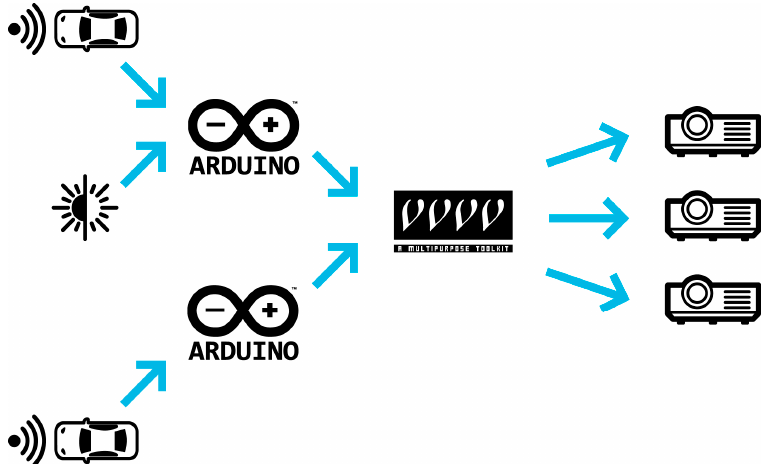
Figure 9. Application interface (image by Rosario Di